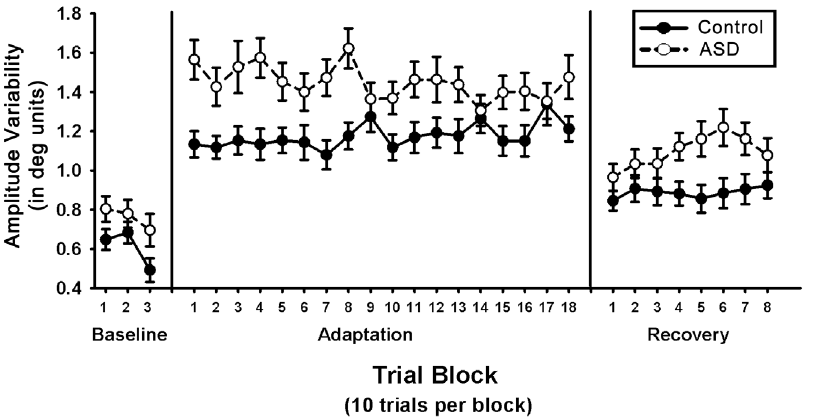
Figure 4. Standard deviation of the amplitude of primary saccades, a measure of trial-wise variability in saccade accuracy, during baseline testing, adaptation and recovery. Data are presented in blocks of 10 trials. Subjects with autism spectrum disorders (ASD) showed greater trial-wise variability in saccade accuracy during each phase of testing (p , .01), but the rates at which variability changed during each of the phases were not different between subjects with ASD and healthy controls (p . .10).